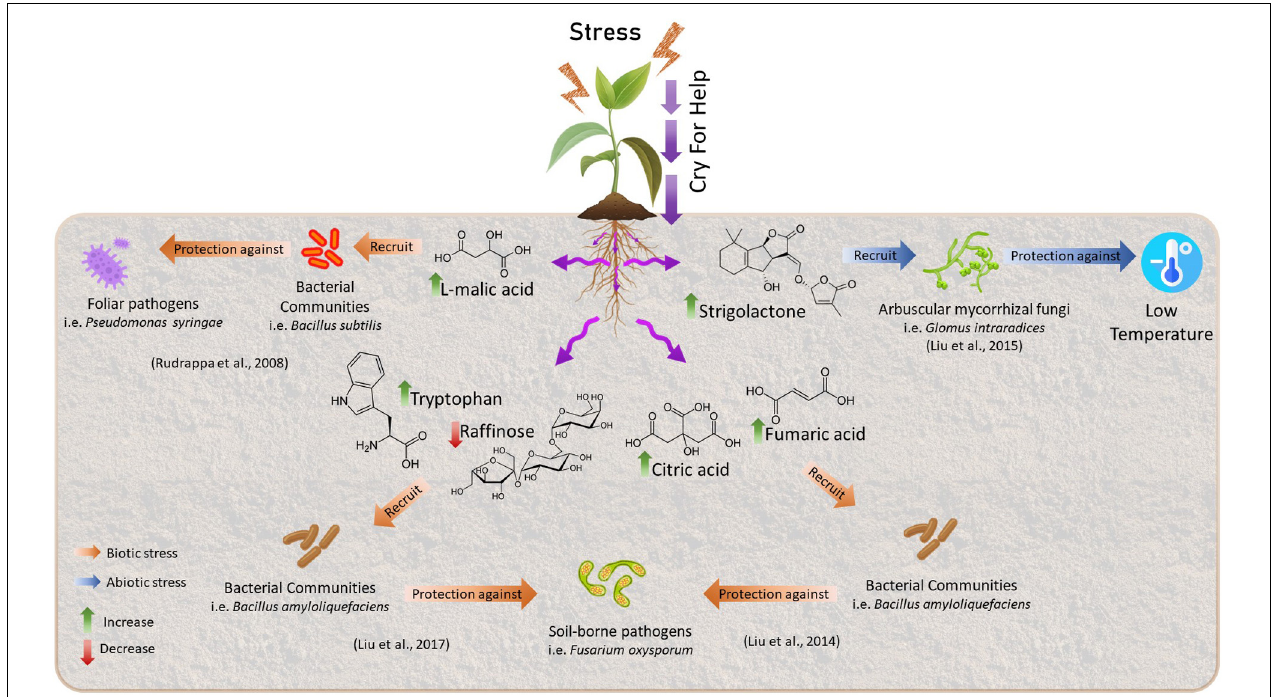
FIGURE 1 | Examples of Cry for help process. Plants undergoing environmental stress could change their radical exudation profiles of primary and secondary metabolites to recruit beneficial microorganisms to counteract the negative effect of the